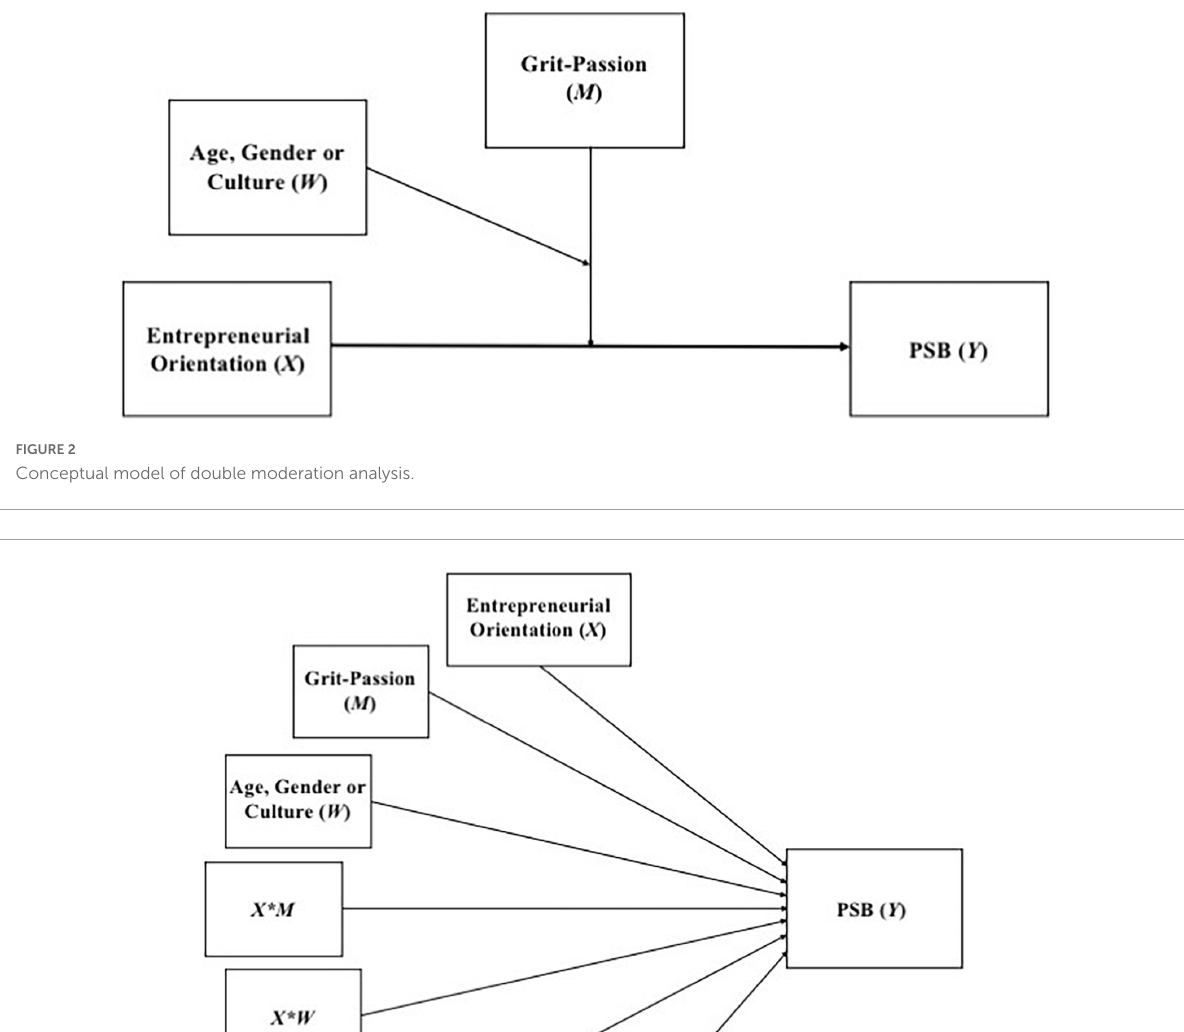
of Starting a Business” (Barrientos-Oradini et al.,